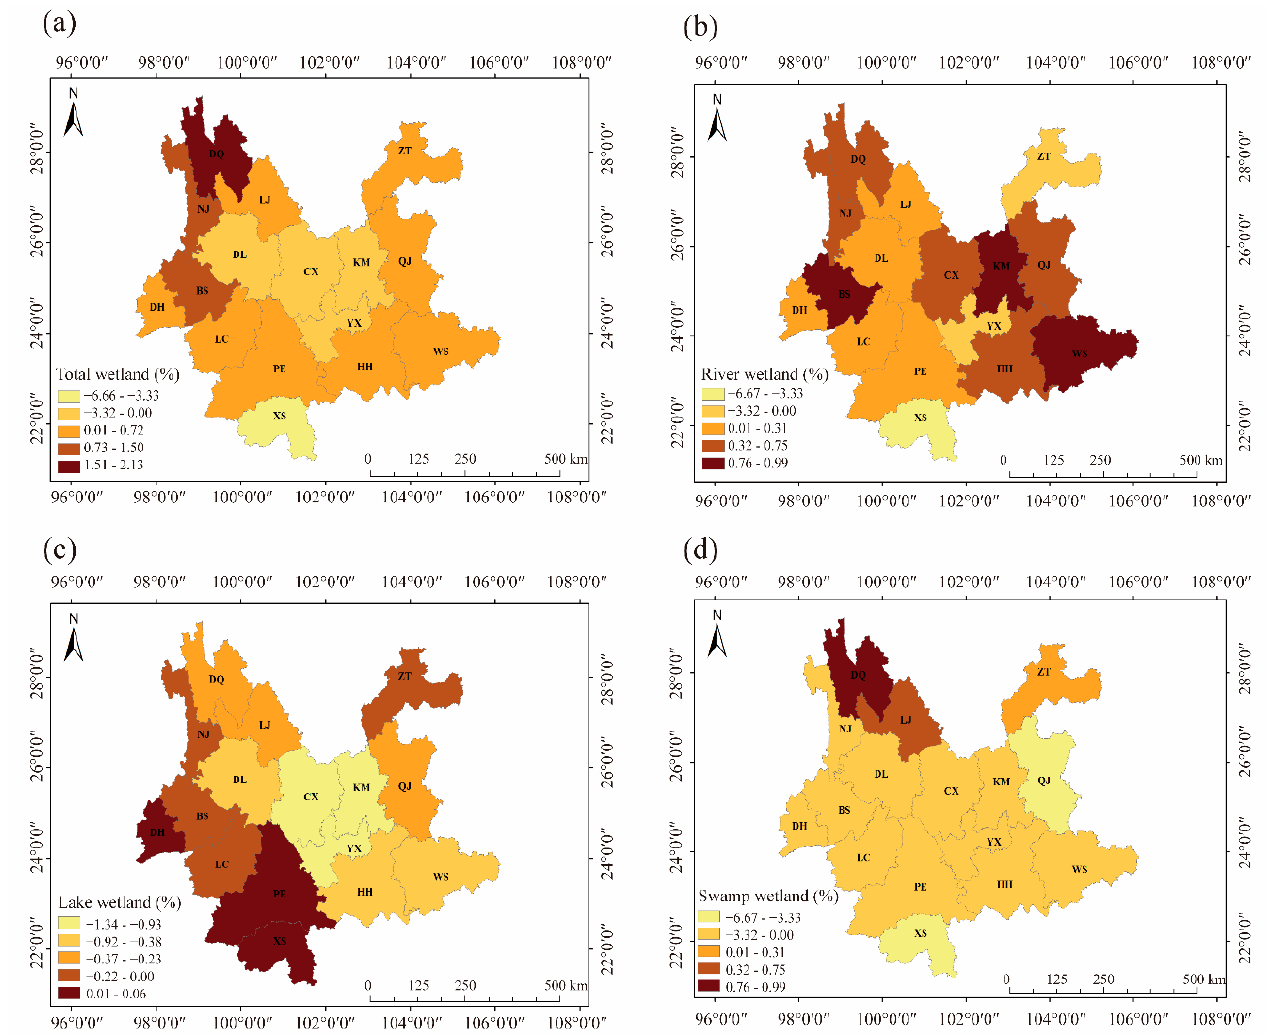
Figure 3. Variations in the ( a ) total wetland, ( b ) river wetland, ( c ) lake wetland, and ( d ) swamp wetland areas in Yunnan Province from 2008 to 2017. KM: Kunming; QJ: Qujing; YX: Yuxi; BS: Baoshan; ZT: Zhaotong; LJ: Lijiang; PE: Puer; LC: Lincang; CX: Chuxiong; HH: Honghe; WS: Wenshan; XS: Xishuangbanna; DL: Dali; DH: Dehong; NJ: Nujiang; DQ: Diqing.